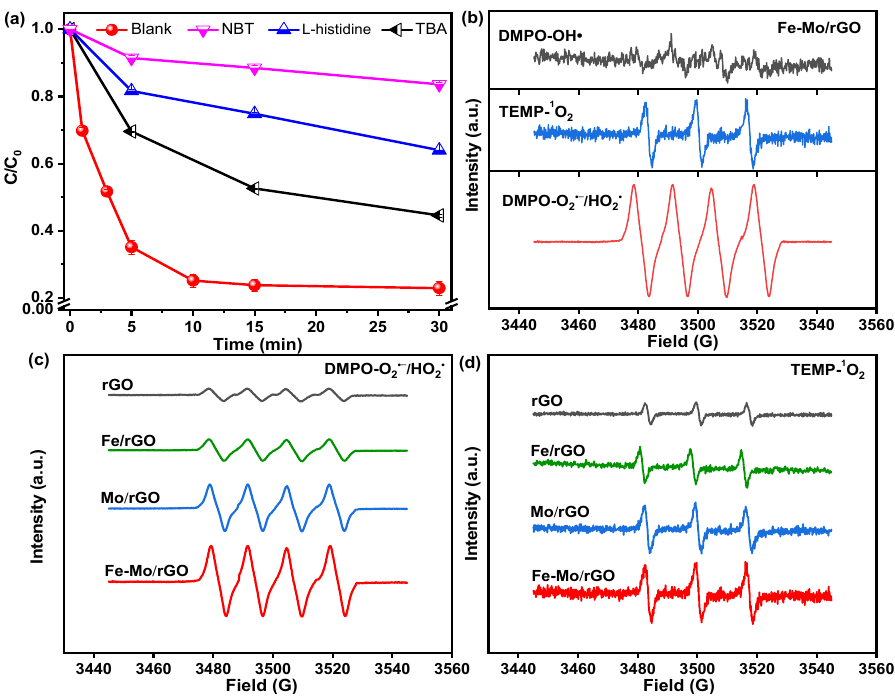
Figure 9. ( a ) The effect of radical scavengers on the SMT removal in the Fenton-like reaction over the Fe-Mo/rGO catalyst. ( b ) ESR spectra for detection of ROS in the heterogeneous Fe-Mo/rGO Fenton-like system. ( c ) ESR spectra for detection of ·O 2 − /HO 2 · in different systems. ( d ) ESR spectra for detection of 1 O 2 in the different systems.